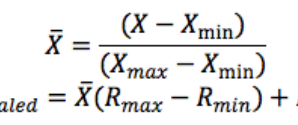
Figure 4. Equation for data scaling based on min-max